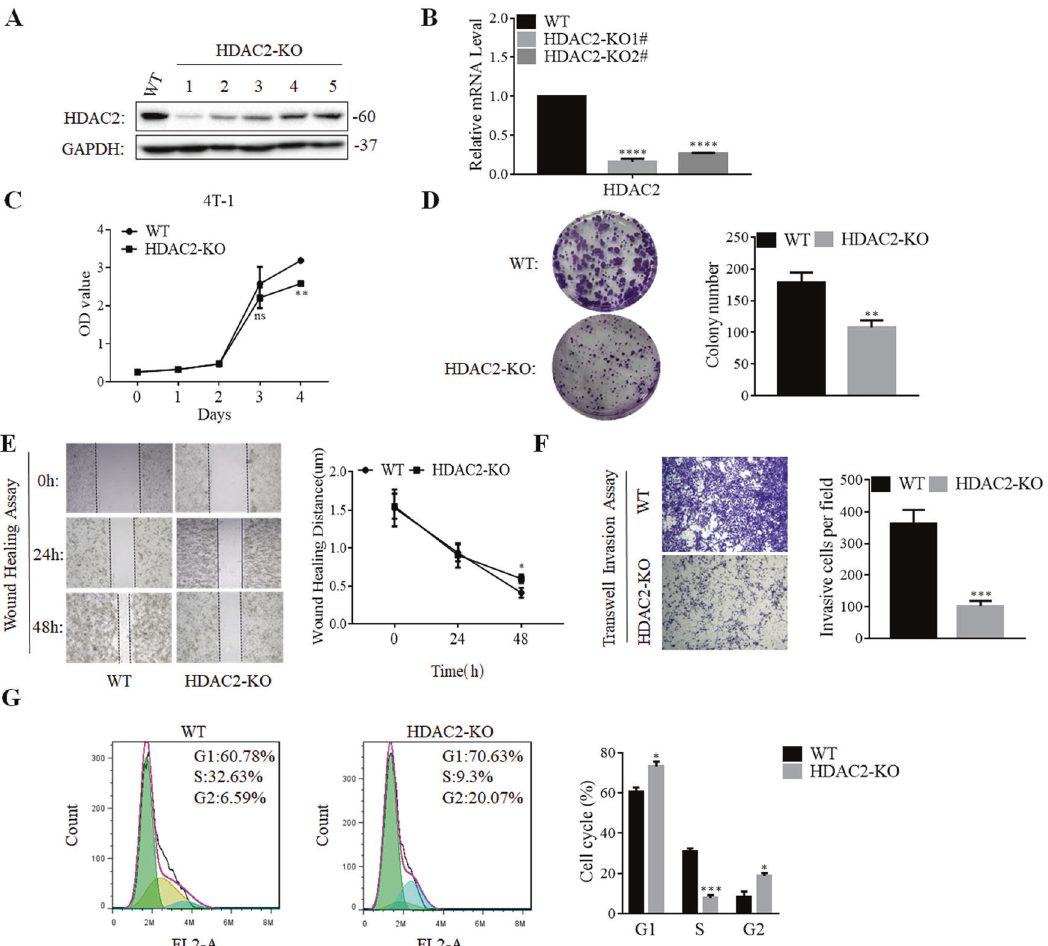
Fig. 2 HDAC2 knockout inhibited the proliferation, suppressed colony formation, migration, and cell cycle of TNBC cells. A , B Western blotting ( A ) and RT-PCR ( B , n = 3) detected the levels of HDAC2 expression in WT cells and HDAC2-KO clones. C , D Cells (WT, HDAC2-KO) viability and colony formation were tested using the CCK-8 ( C ) and colony-formation analysis ( D ), respectively ( n = 3). E , F The wound healing ( E ) and Transwell assay ( F ) results showed the migration of WT and HDAC2-KO cells ( n = 3). G Flow cytometry analysis showed the cell cycle of WT and HDAC2-KO cells ( n =